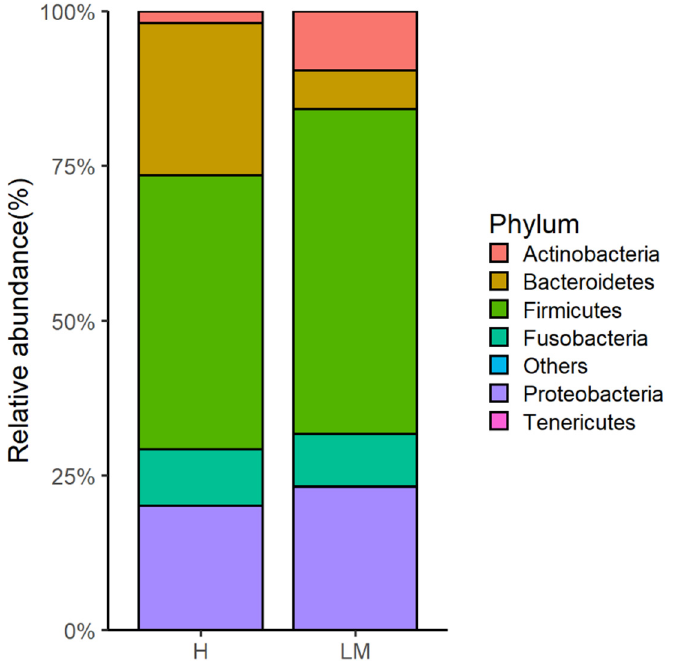
Figure 2. Relative abundance at the phylum level between healthy (H) and lymphoma (LM) dogs.